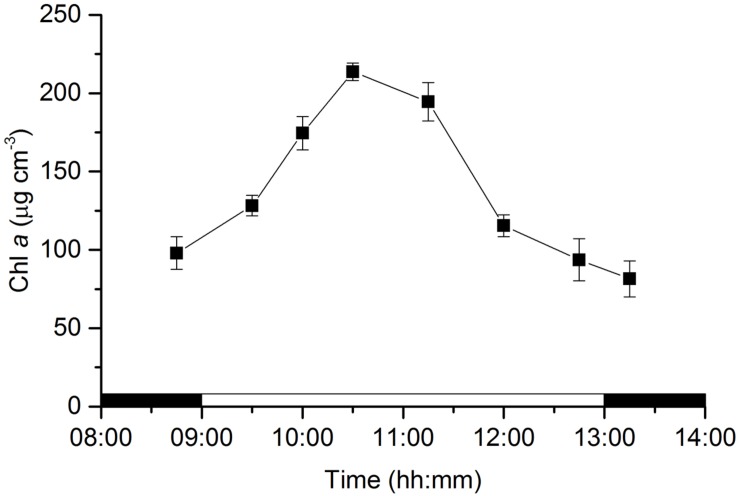
Changes in microphytobenthos biomass (chlorophyll a) in an intertidal sediment photic zone (0–0.5 mm) over a diel emersion period (mean ± standard deviation; n = 3). The illumination period was between 9 AM and 1 PM at a constant photon irradiance of 150 μmol photons m-2 s-1.